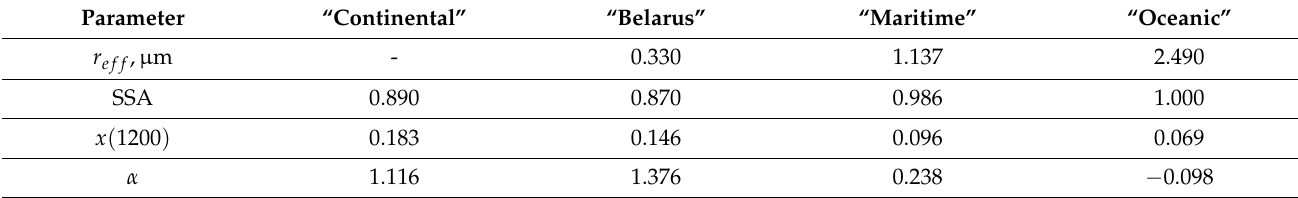
Table 9. Optical and microphysical parameters of aerosol models.